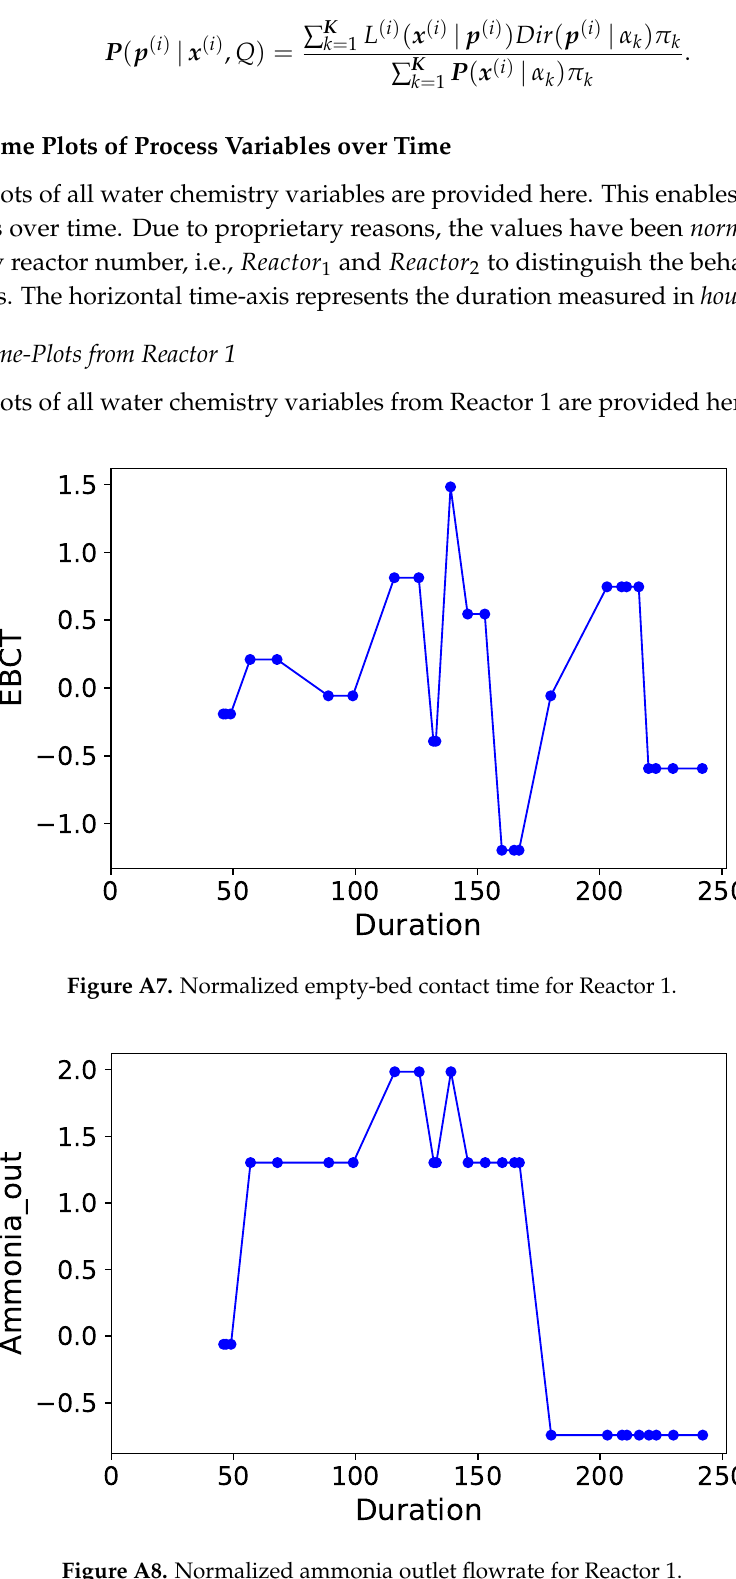
Figure A8. Normalized ammonia outlet flowrate for Reactor